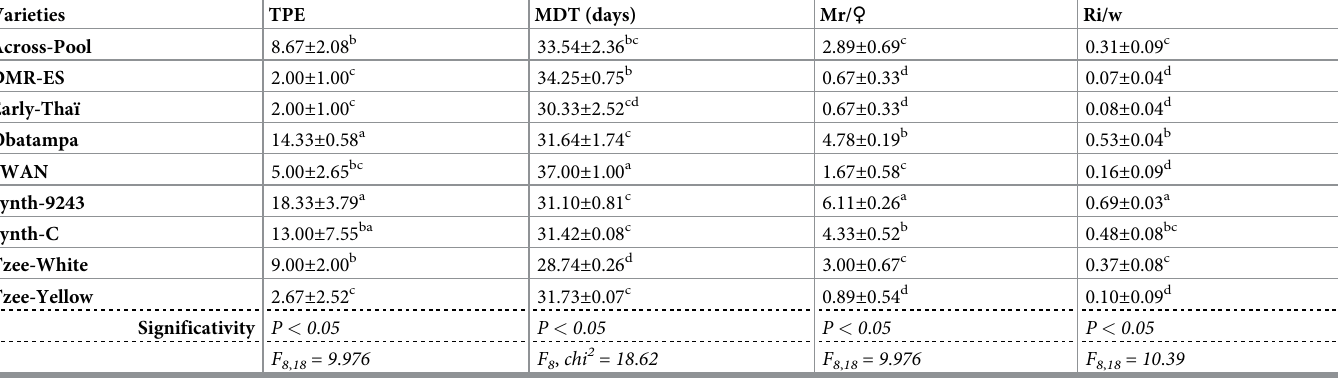
Table 1. Effect of nine maize varieties on duration of development, number of emerged F 1 progeny of P . truncatus , multiplication rate per female, rate of increase per week and adults weight. Varieties